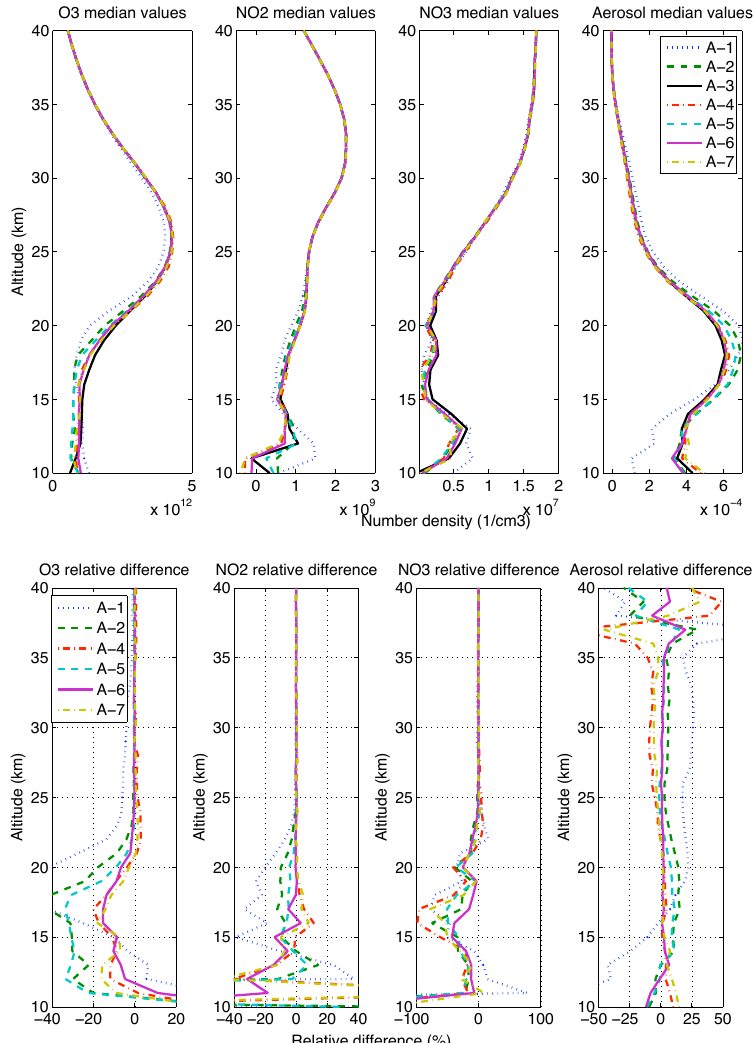
Fig. 9. Sensitivity of O 3 , NO 2 , NO 3 and aerosol extinction (at 500nm) on selection of aerosol model. Seven aerosol models are compared (denoted with different line types and colours. Top row: median profiles and bottom row relative difference compared to second order polynomial model which is used in the operational GOMOS processing. From left: O 3 , NO 2 , NO 3 and aerosol extinction at 500nm. See text for the different aerosol models